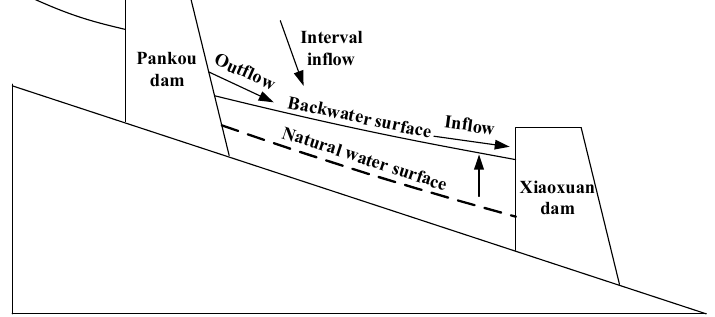
Figure 1. Schematic diagram of the cascade reservoirs’ hydraulic connection.